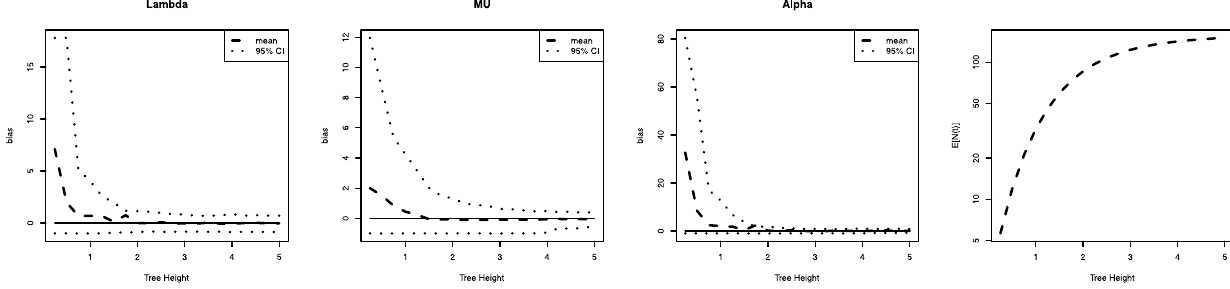
Figure 4. The bias in the maximum likelihood estimates of the speciation and extinction rate. The true parameters were l ~ 4 , m ~ 1 and a ~ 1 . The figure shows that the bias decreases with larger trees (by simulating trees with a larger time T ). The expected number of species ( E ½ N ( T ) (cid:3) ) is presented to illustrate the increase in diversity over time.